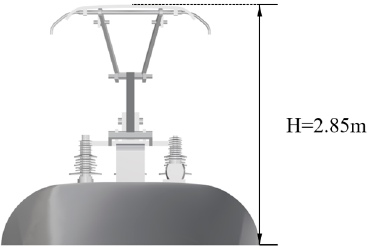
Figure 5. Side view of the computational model.